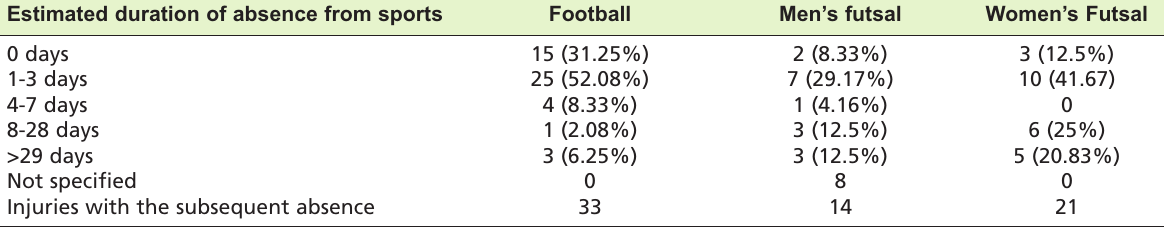
Estimated duration of absence from sports Table II: